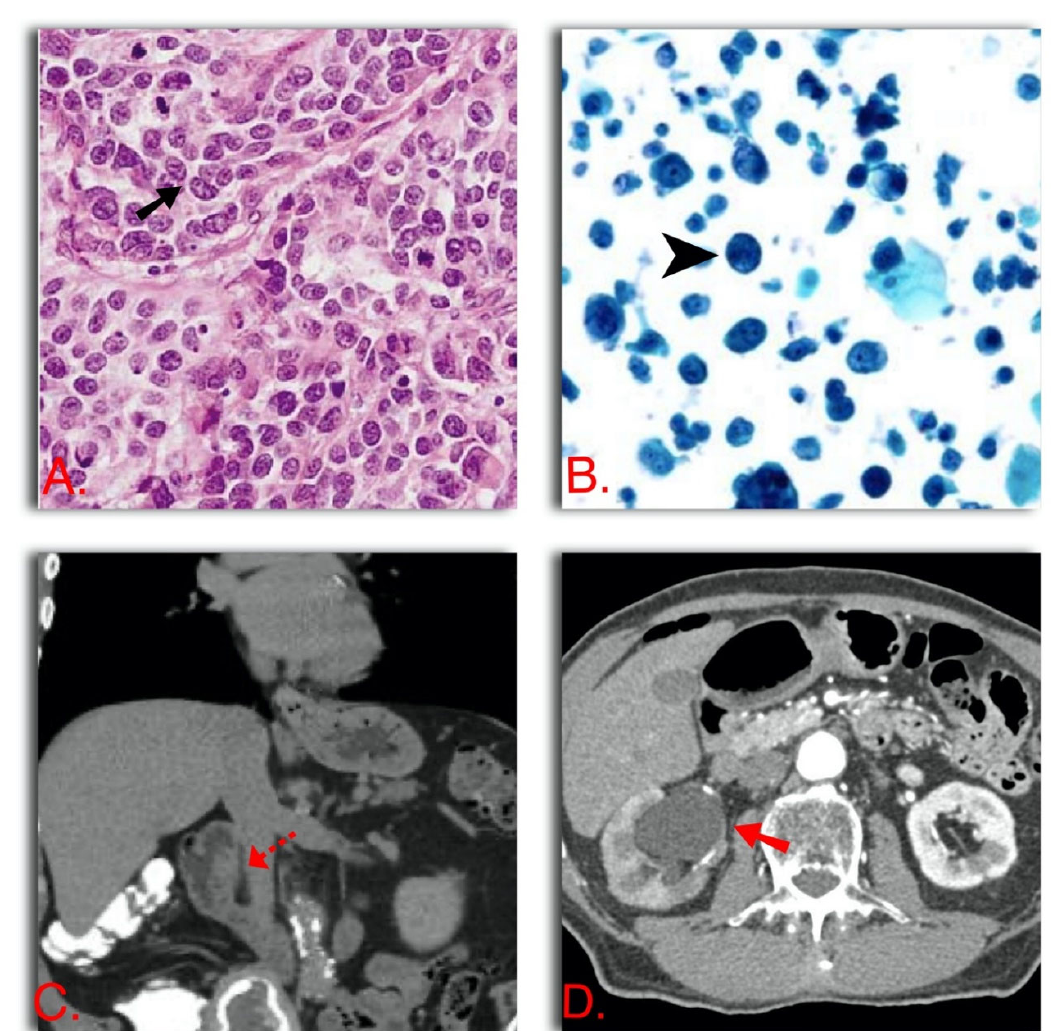
Figure 2. Predictive factors for ≥ pT2 UTUC. ( A ) Hematoxylin ‐ eosin 20× cHG transitional cell carcinoma, diagnosed with URS biopsy of a renal pelvis tumor. ( B ) Positive urinary cytology (in this case HG). ( C ) Local invasion of UTUC (periureteric fat extension). ( D ) Right hydronephrosis secondary to proximal ureteral transitional cell carcinoma.